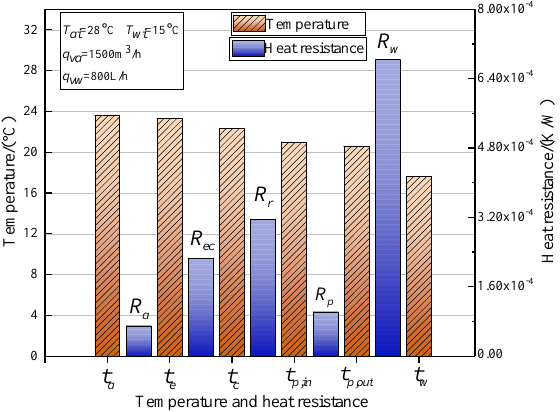
Figure 18. Distribution of temperature and heat resistance ( T w,in = 15 °C).